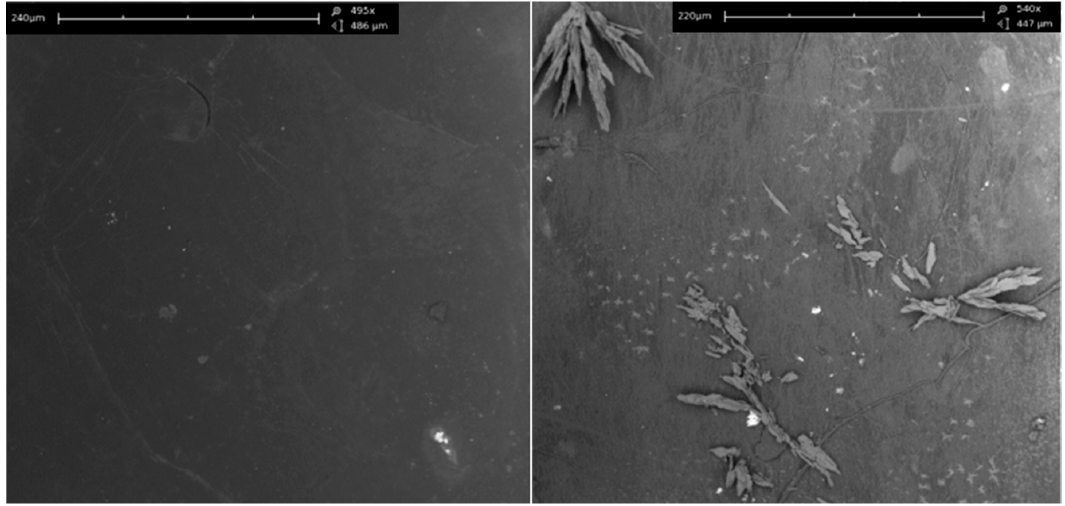
Figure 14. SEM pictures of PEEKN5 alone ( left ); with silver complex 24 h ( right ).